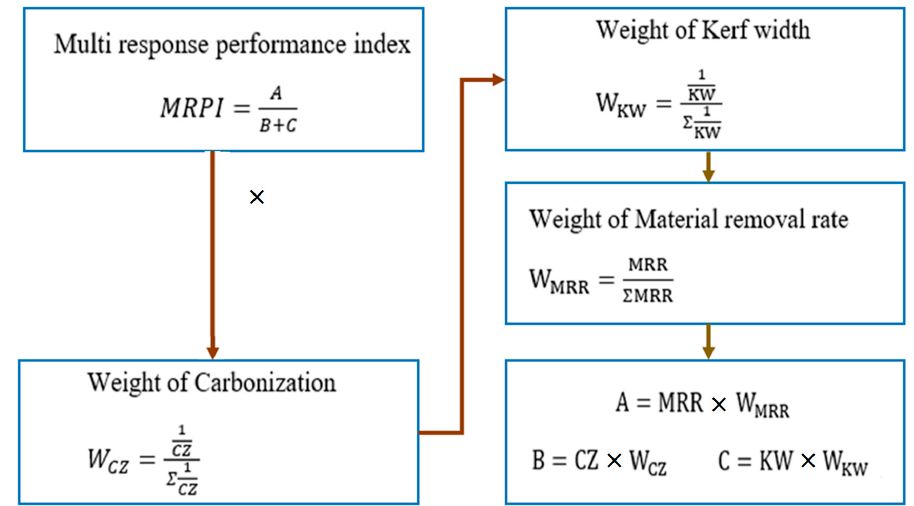
Figure 4. Procedure to calculate MRPI.